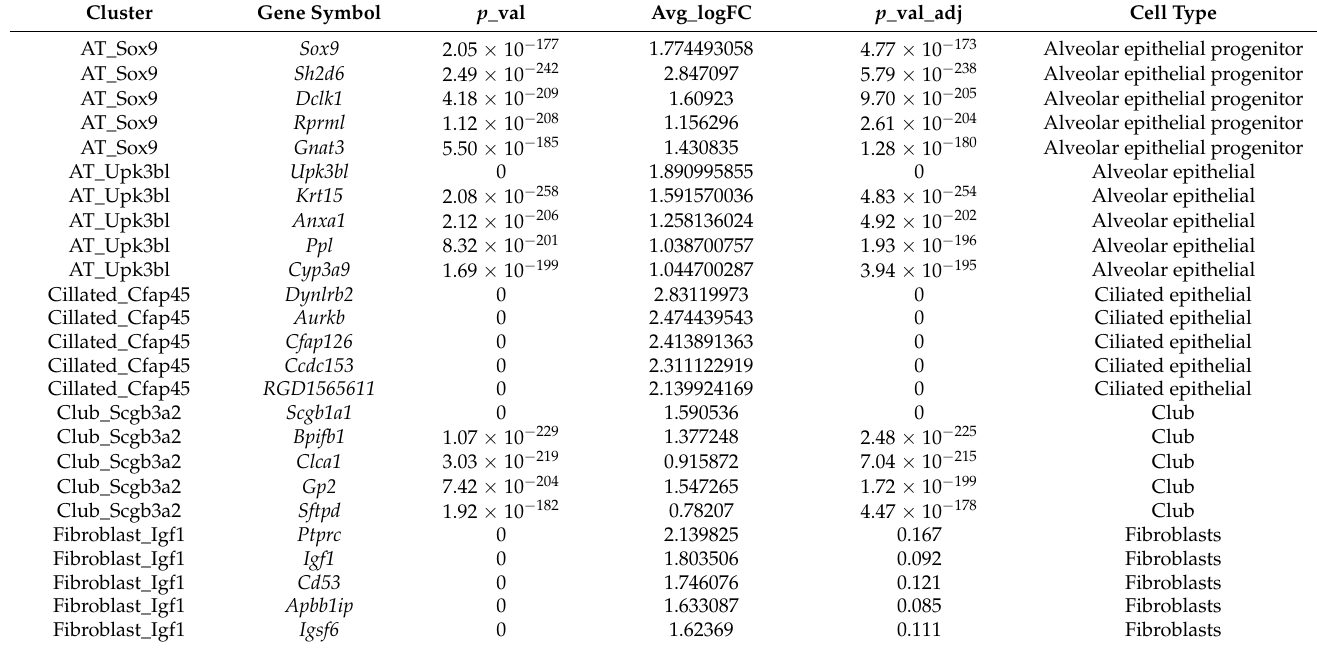
Table 1. Annotation of pulmonary epithelial cell subtypes based on the maker